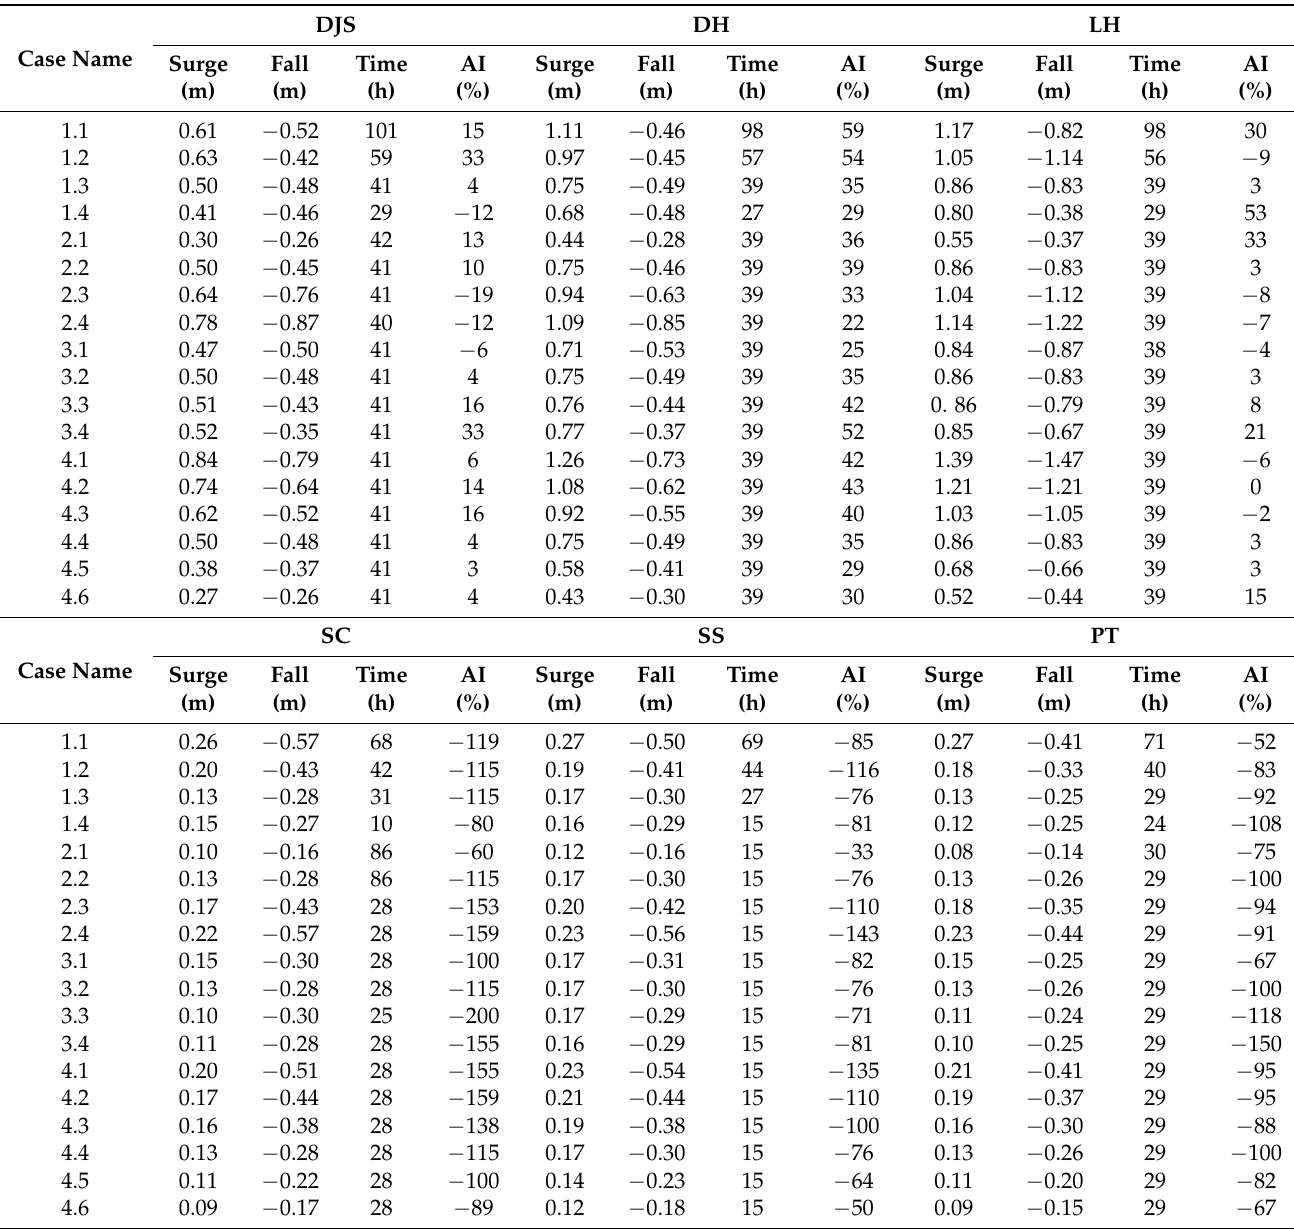
Table 3. The model results of surge, fall, time, and the value of AI at the six stations. Surge (m): Surge max ; fall (m): Fall max ; time: occurrence time of surge reaches the peak (from a cold start); AI: asymmetry